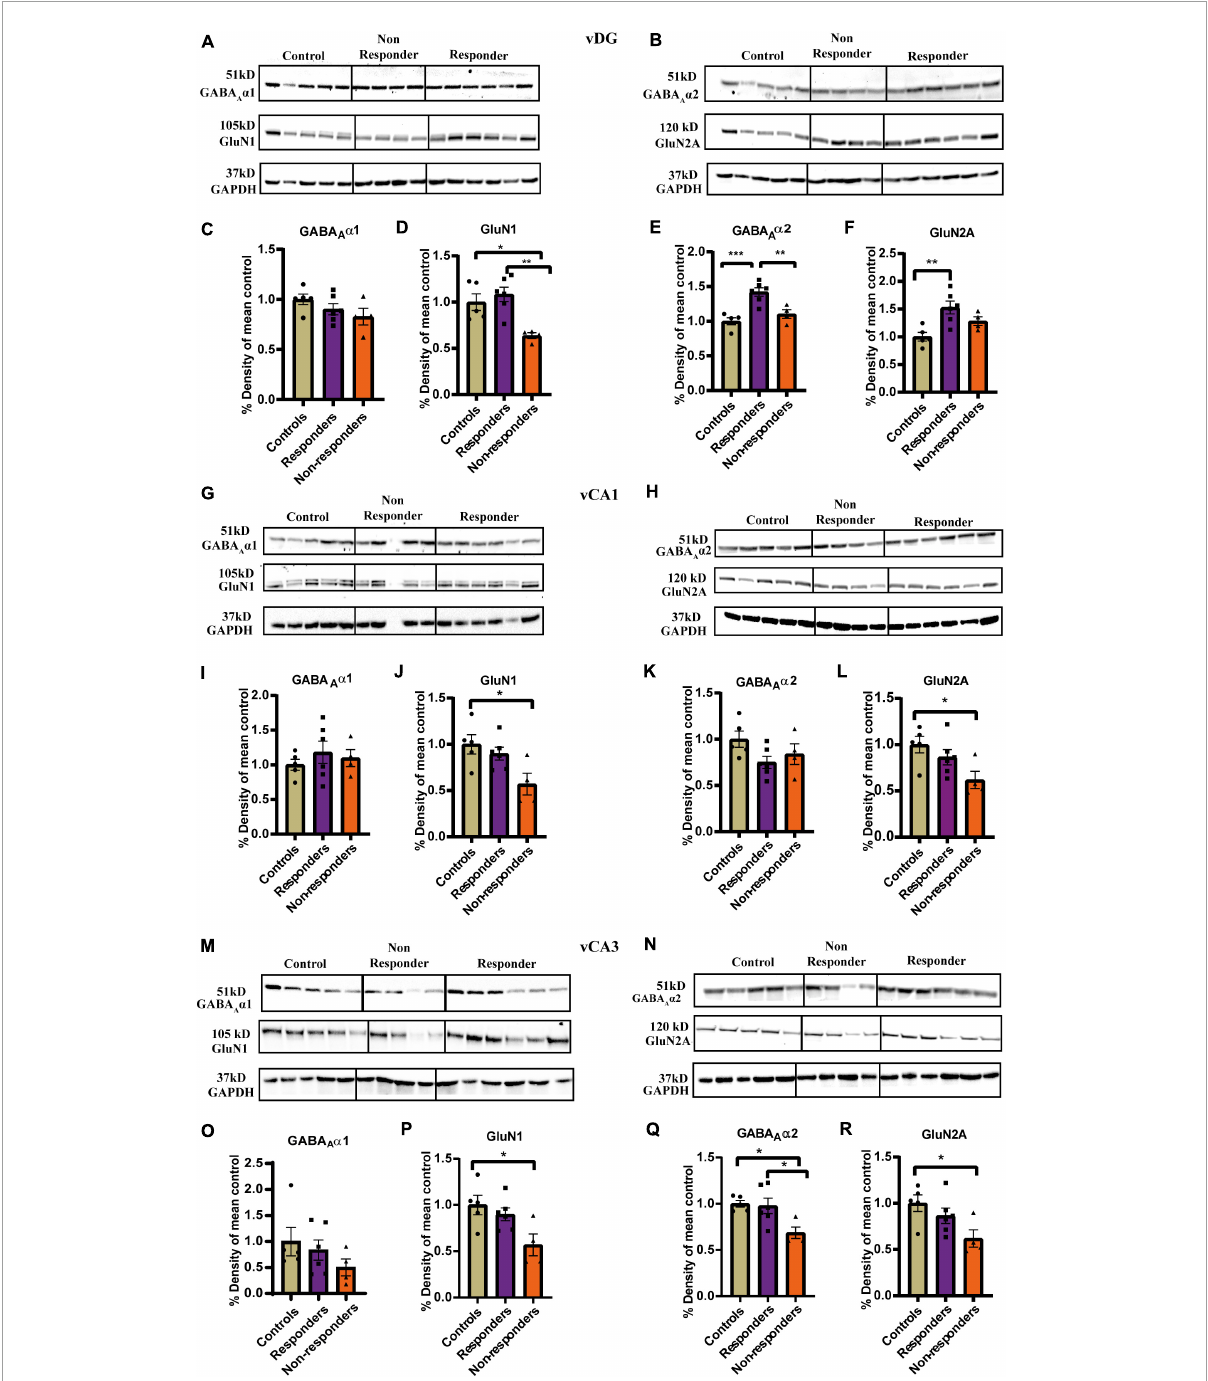
FIGURE5 Experssion profile of GABA A α 1, GABA A α 2, GluN1, and GluN2A in the ventral hippocampus between controls , treatment responders and non - responders . (A) Gel images of GABA A α 1, GluN1, and GAPDH for controls , treatment responders and non - responders in the vDG. (B) Gel images of GABA A α 2, GluN2A, and GAPDH for controls , treatment responders and non - responders in the vDG. (C) GABA A α 1 expression level was similar between the theree groups in vDG [Ordinary one-way ANOVA (F ( 2 , 12 ) = 1.717, p = ns)]. (D) GluN1 levels was the least in the non - responders while controls and responders had almost similar level of expression in vDG [Ordinary one-way ANOVA (F ( 2 , 12 ) = 8.486, p = 0.005); Bonferroni’s post-hoc test p * < 0.05, p ** < 0.01]. (E) GABA A α 2 levels were highest in the responders while controls and responders showed similar level of expression in vDG [Ordinary one-way ANOVA (F ( 2 , 12 ) = 15.15, p = 0.0005); Bonferroni’s post-hoc test p ** < 0.01, p *** < 0.0001]. (F) GluN2A expression in the responders was significantly higher than controls but no significant difference was found with respect to non - responders in vDG [Ordinary one-way ANOVA (F ( 2 , 12 ) = 7.679, p = 0.0071); Bonferroni’s post-hoc test p ** < 0.01]. (G) Gel